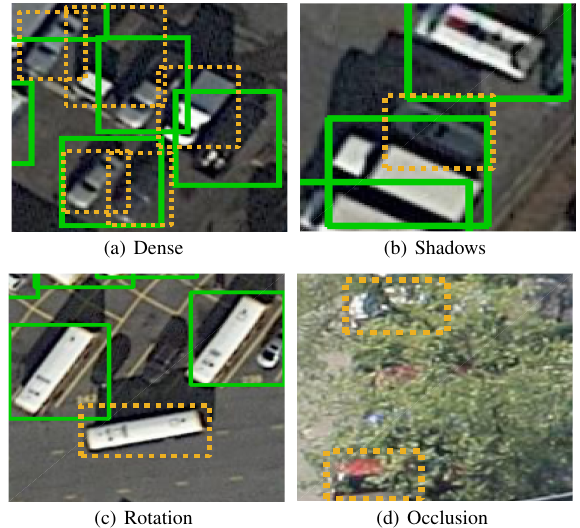
Figure 1. Dense, arbitrary orientation, shadows, and occlusion are typical challenges for vehicle detection in aerial imagery. Green boxes indicate detection results of Faster R-CNN. Orange dashed boxes mark undetected